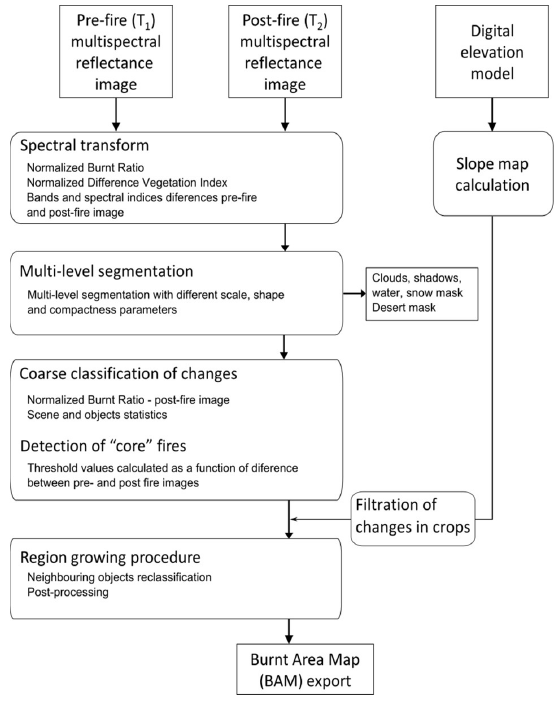
Figure 2. Burnt area mapping workflow.